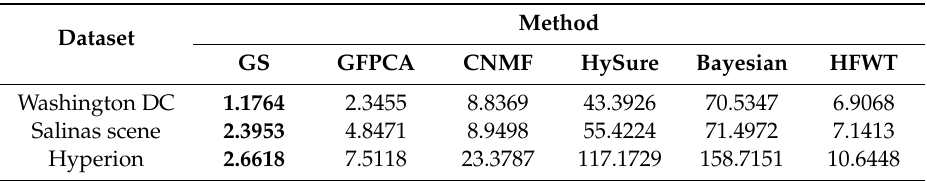
Table 5. Computing time (seconds) of each